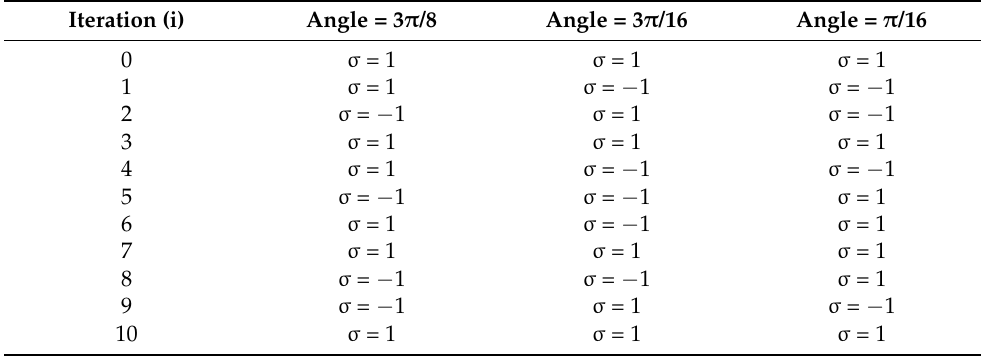
Table 2. Iteration (i) and rotation direction ( σ ) for the CORDIC-DCT.